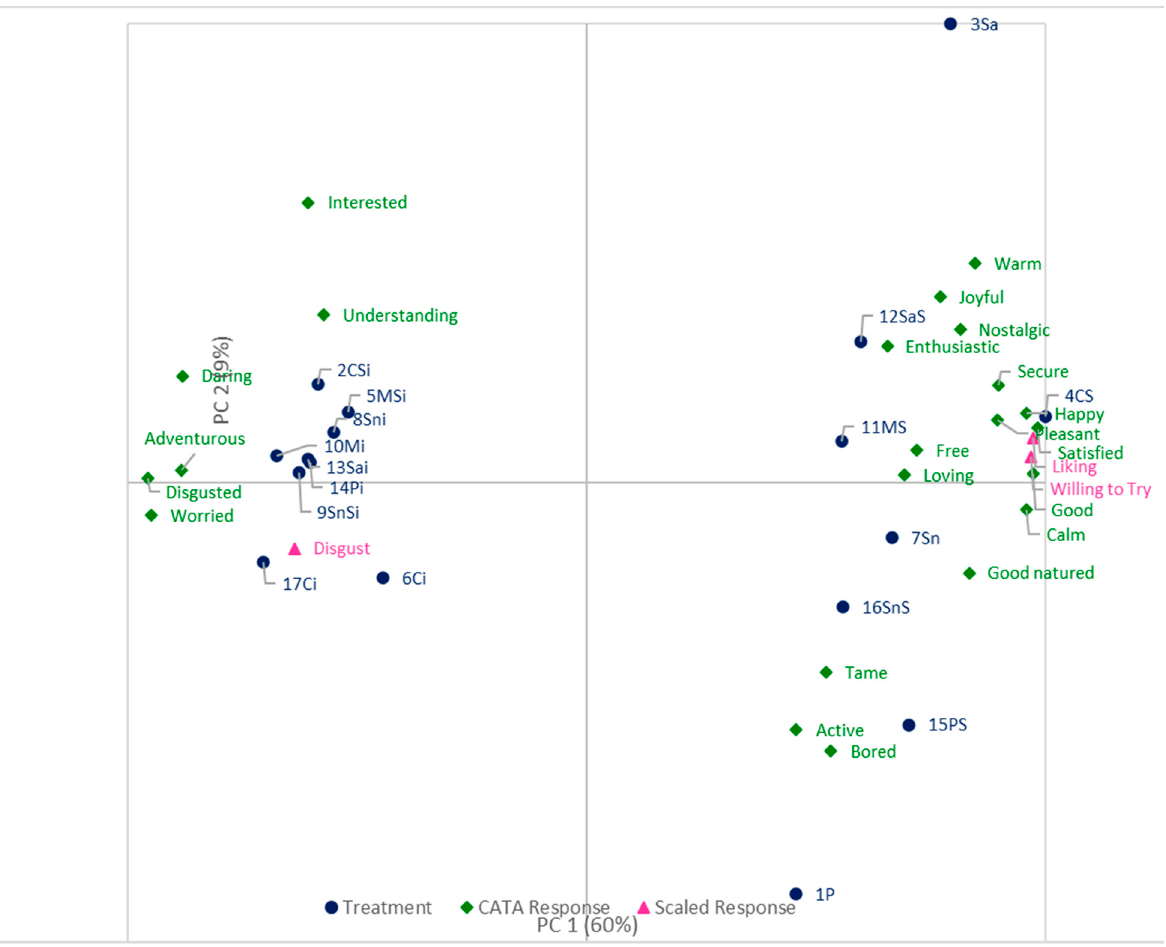
Figure 2. Biplot of the first two principal components, PC1 and PC2. The treatments are in blue, the CATA emotions from the EsSense Profile ® are in green, and the scaled responses are in pink.